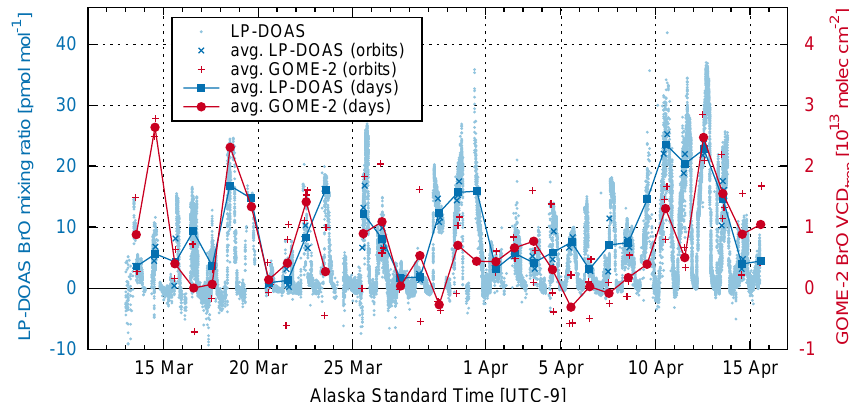
Fig. 17. Same as Fig. 16 but showing BrO mixing ratios measured by LP-DOAS. Both ordinates are scaled corresponding to a mixing height of 345m. Correlation in Fig.